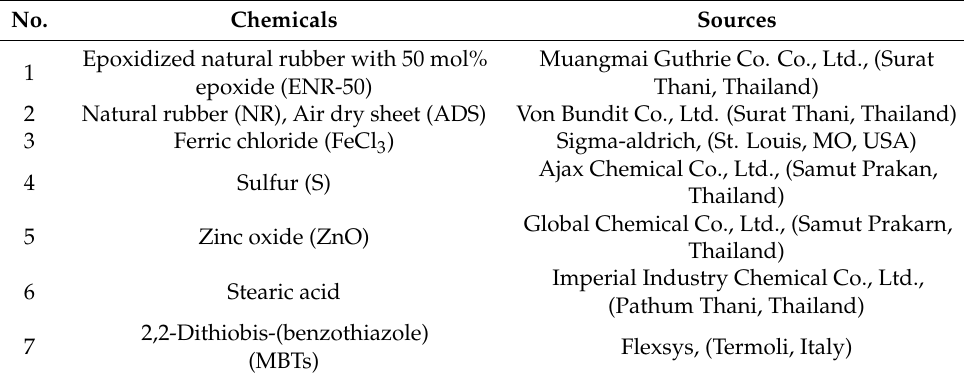
Table 1. Characteristics and sources of materials